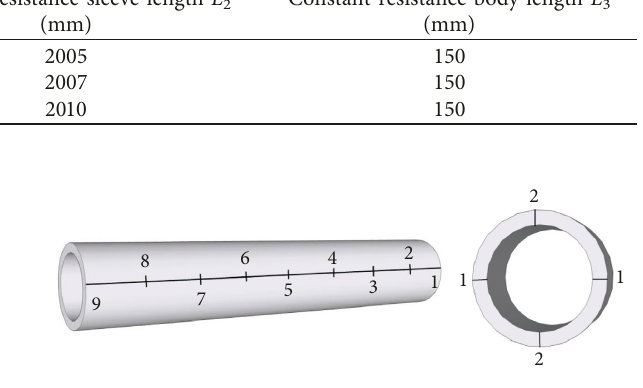
Figure 5: NPR anchor cable